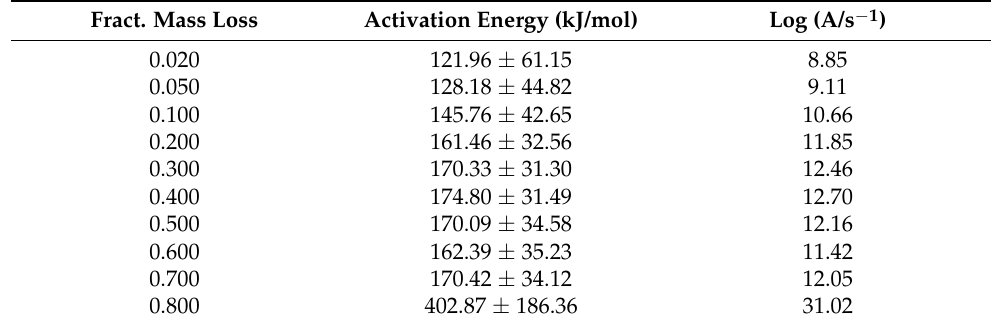
Table 1. Activation energy and pre-exponential coefficient as a function of the degree of reaction determined by the Ozawa–Flynn–Wall method for pine wood.